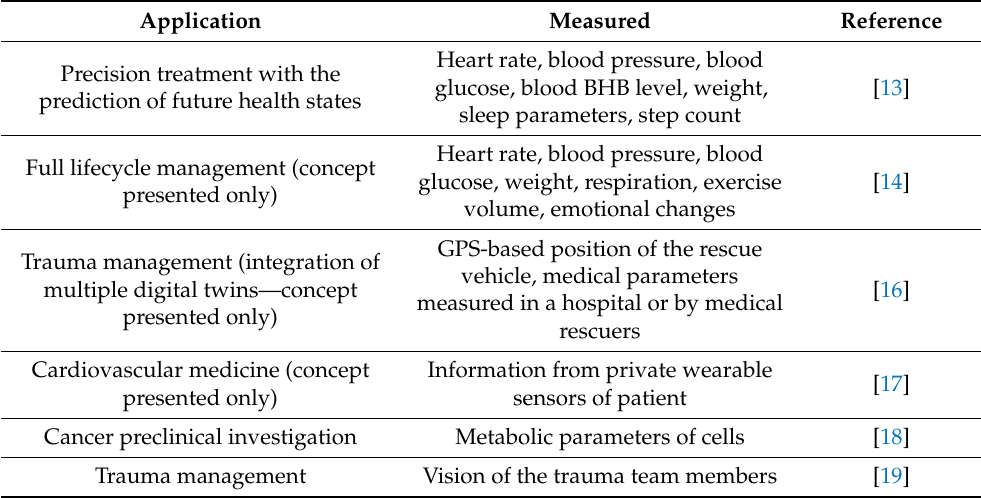
Table 1. Review of medical applications of virtual